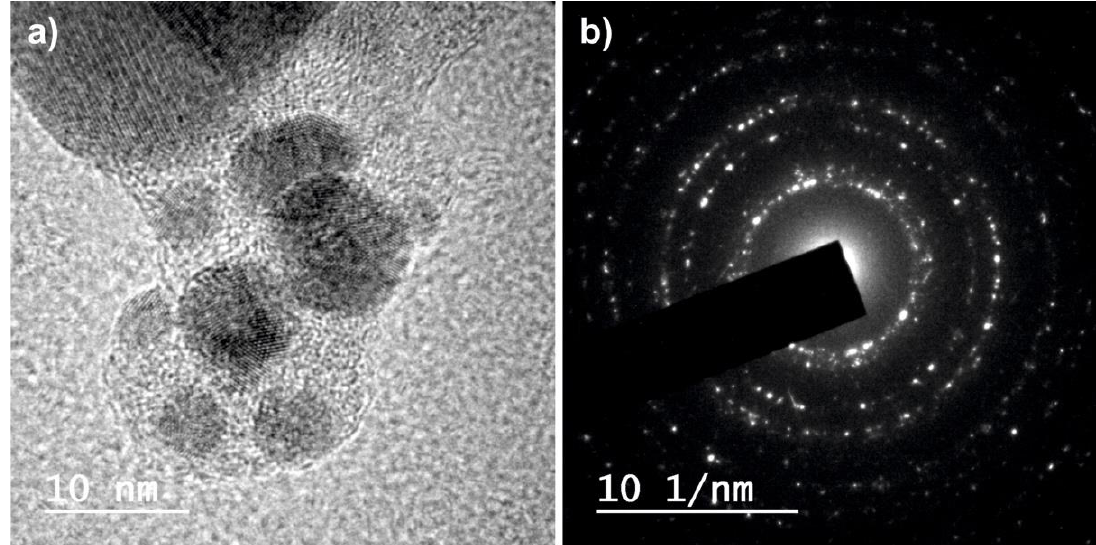
Figure 5. ( a ) HRTEM image and ( b ) SAED of Ag crystalline nanoparticles obtained in water after three re-irradiations with IR-picosecond laser. The diffraction peaks from A, B, C, D, are consistent with Ag, showing 0.235, 0.204, 0.144, 0.123, 0.118, 0.101 nm, and the corresponding (1 1 1), (2 0 0),